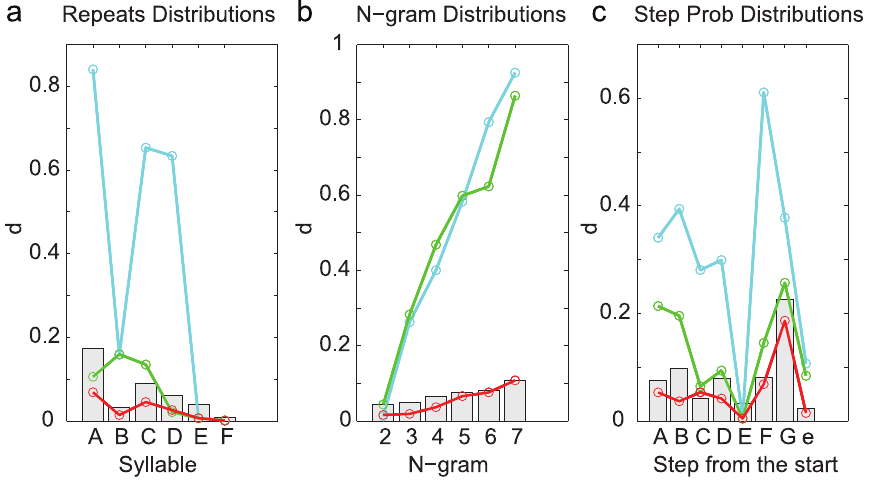
Figure 6. Summary of the differences between the model-generated and observed distributions (Bird 1). The d -values are shown for all distributions. Cyan curves are from the Markov model, green curves from the Markov model with adaptation, and the red curves from the POMMA. The gray bars are the benchmarks obtained from the observed syllable sequences charactering the d -values expected due to the finite size of the samples. a . The repeat distributions. b . The N-gram distributions. c . The probabilities of observing syllables and the end in a given step from the song start.